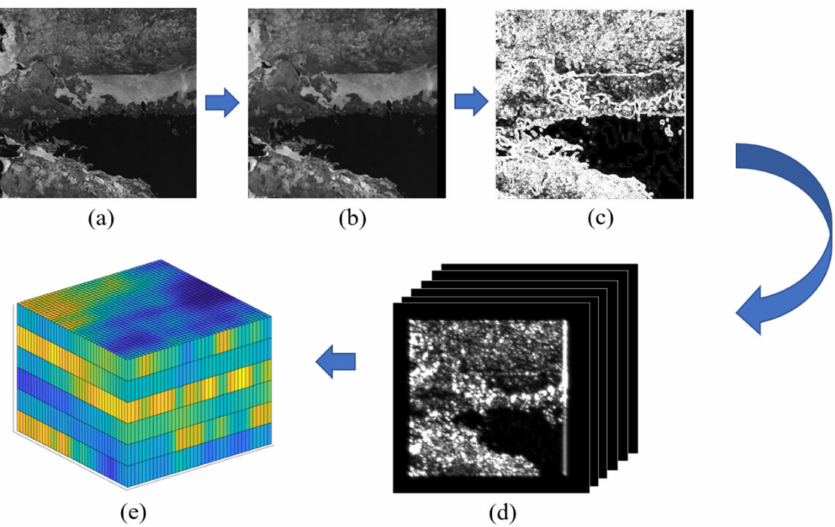
Figure 7. Optimized 3DPC description process: ( a ) The original image; ( b ) Preprocessed image; ( c ) Second-order gradient amplitude of the image; ( d ) Phase direction magnitude map of the image; ( e ) Optimized 3DPC